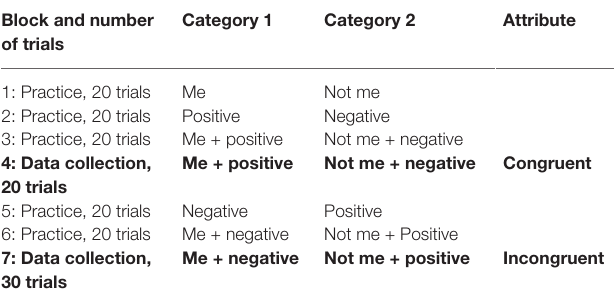
TABLE 1 | The order of the procedure in the implicit association